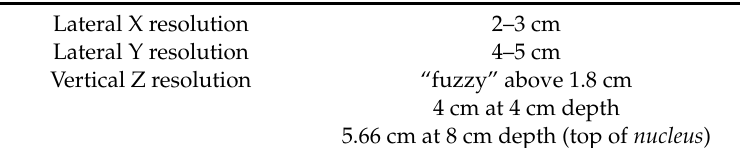
Table 3. Absolute final accuracy for a 3D GPR grid.